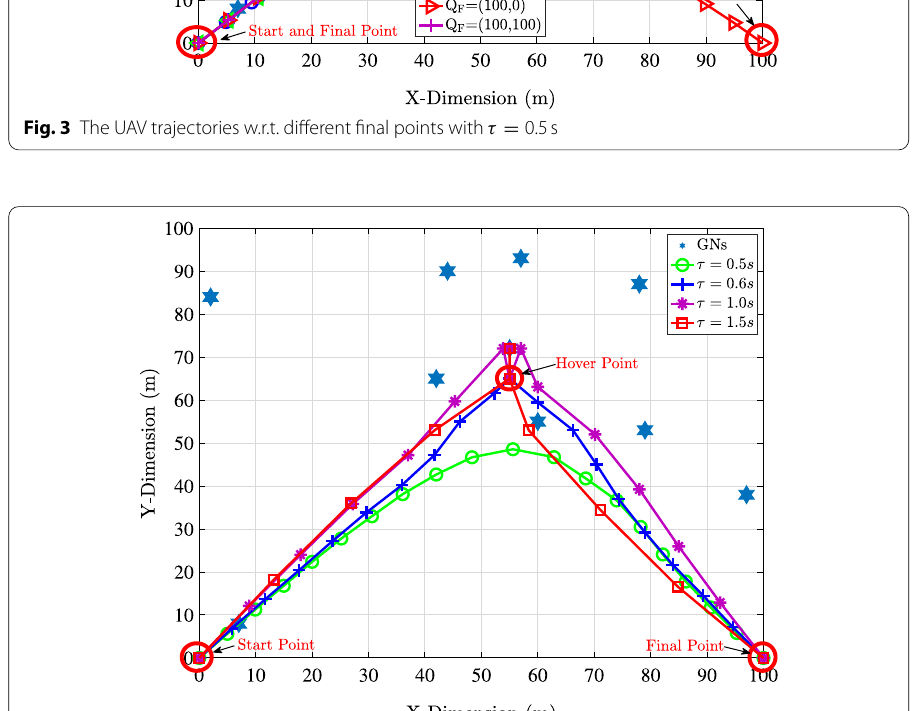
Fig. 4 The UAV trajectories w.r.t. different QoE requirement of time‑sensitive tasks at collaborative offloading